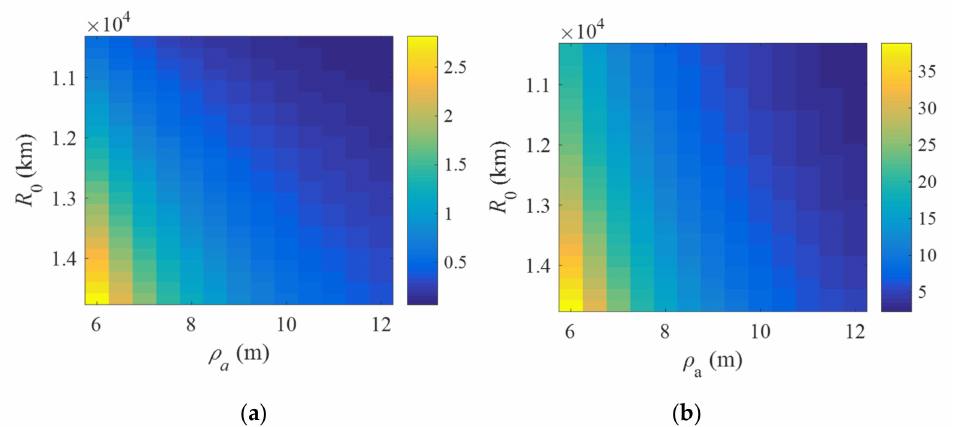
Figure 7. Dependency between the phase error and ρ a and R 0 for the S band system. ( a ) Targets with constant speeds and ( b ) accelerating targets. In the figures, the color indicates the value of the phase error, and the unit is radian.